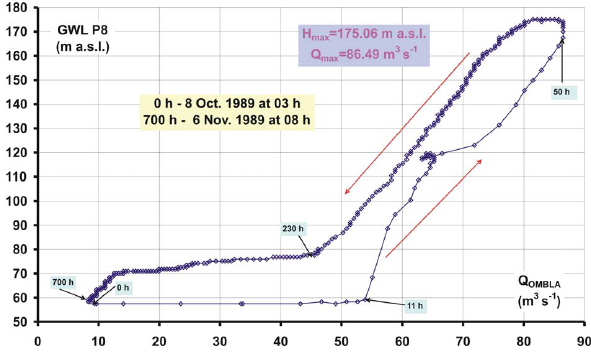
Figure 5 Fig. 5. Relationship between hourly Ombla Spring discharges and